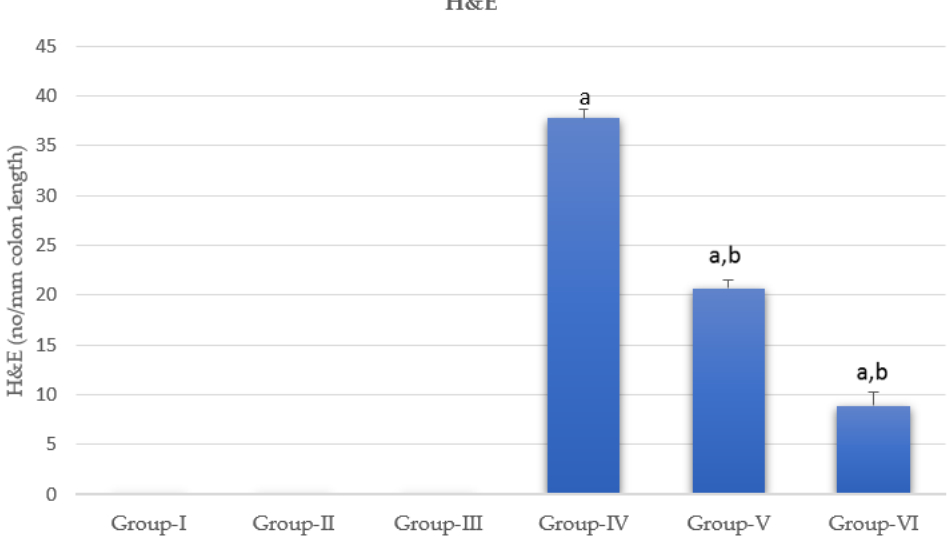
Figure 5. Quantitative assessment of dysplastic foci within different groups. a represents statically significant differences at ( p < 0.05), compared different groups with Group-I and b represents statically significant differences at ( p < 0.05), compared different groups with Group-IV.